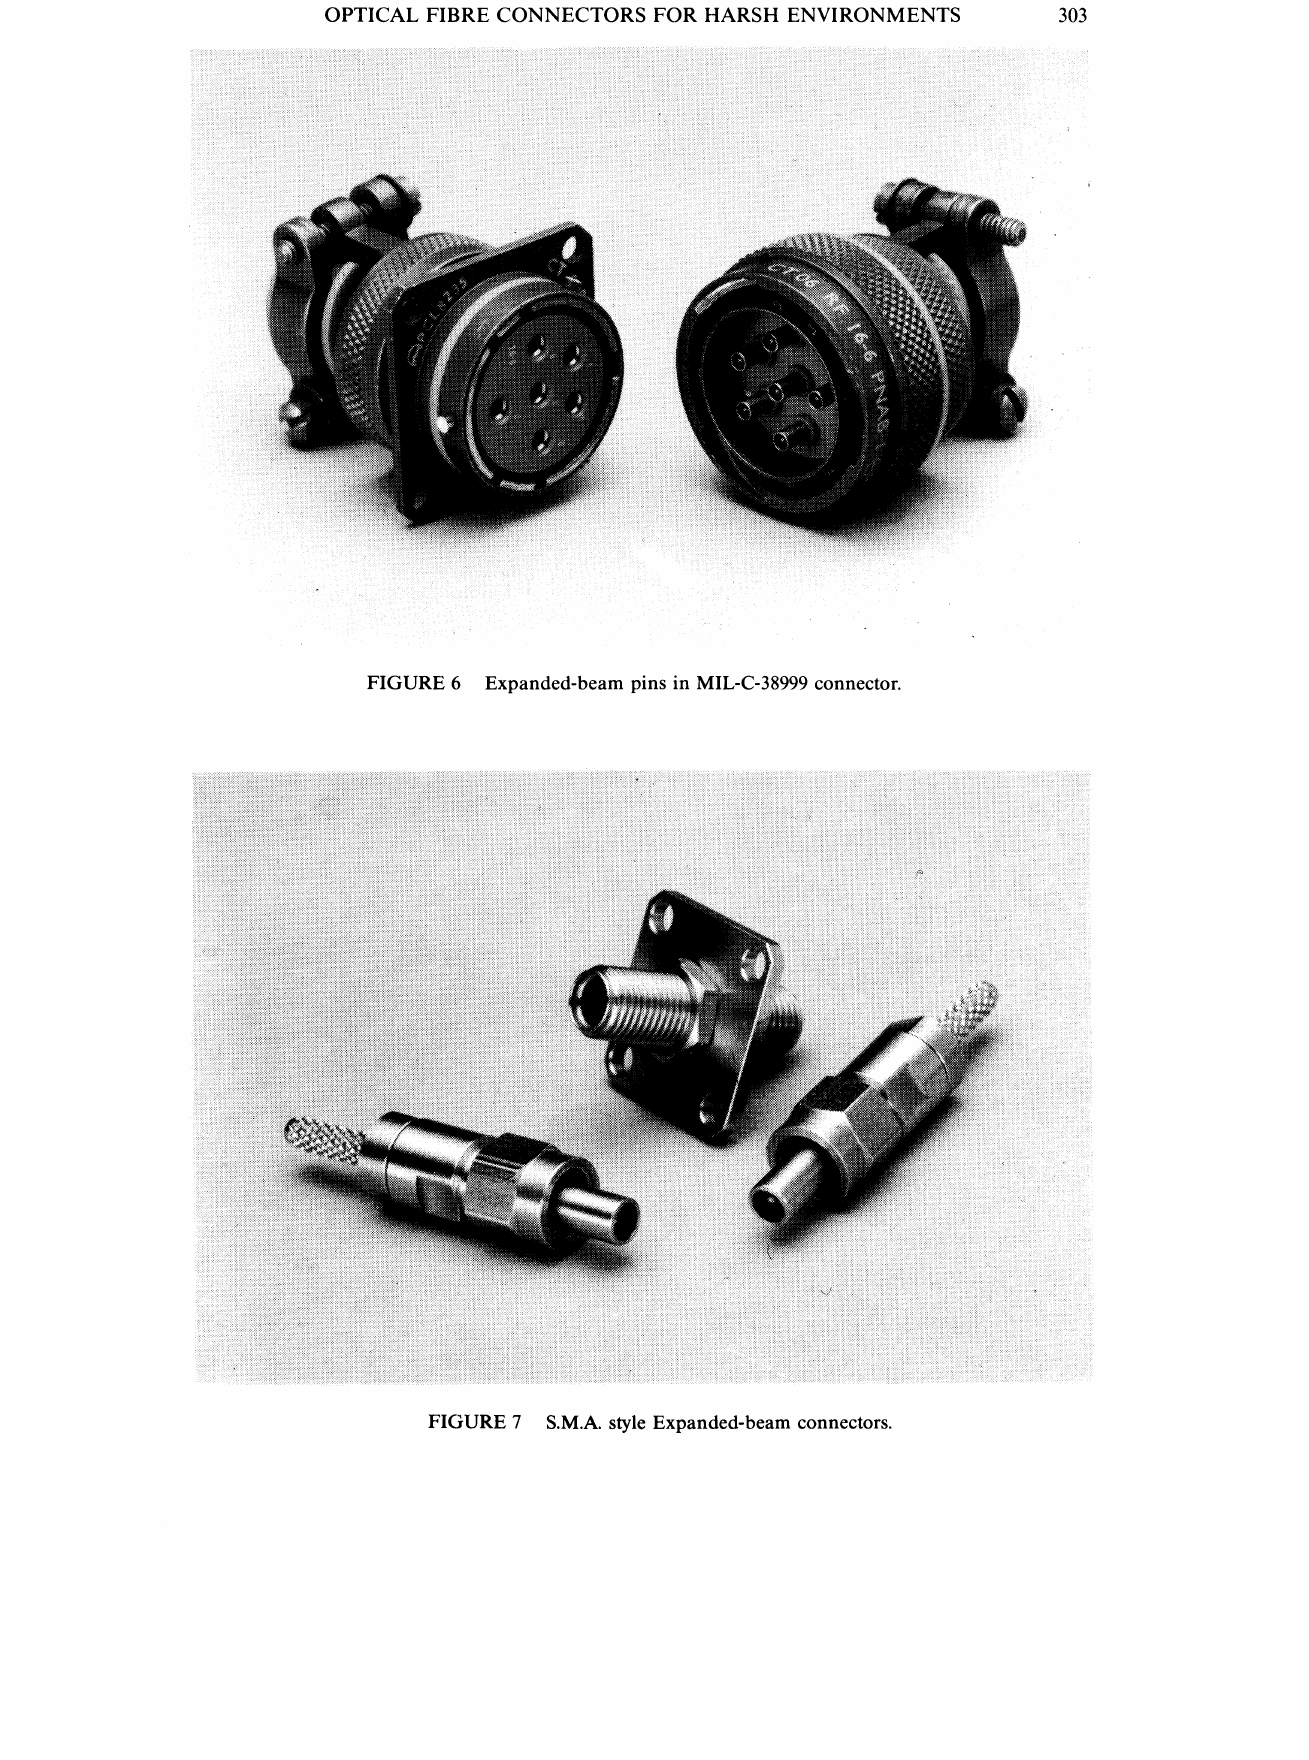
FIGURE 6 Expanded-beam pins in MIL-C-38999 connector.